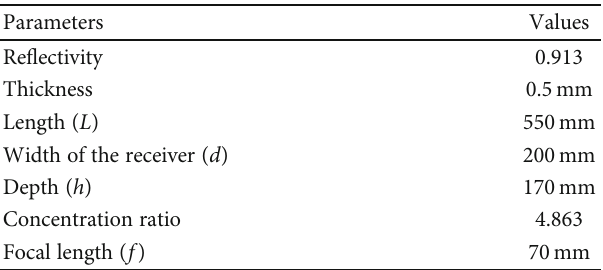
Table 2: Speci fi cations of the secondary re fl ector.